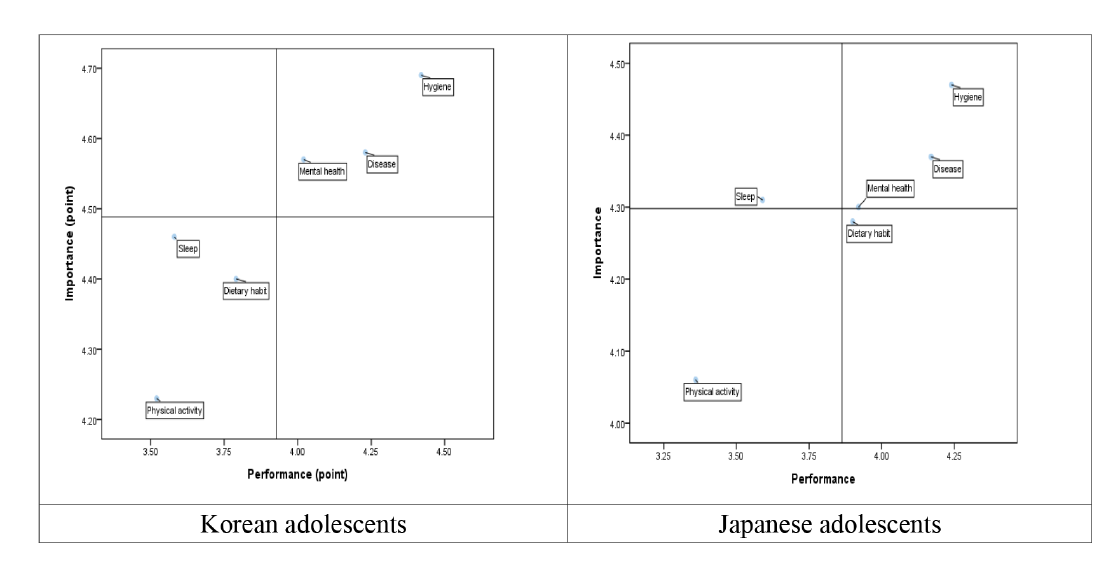
Fig. 2. IPA Matrix – Factors (countries).